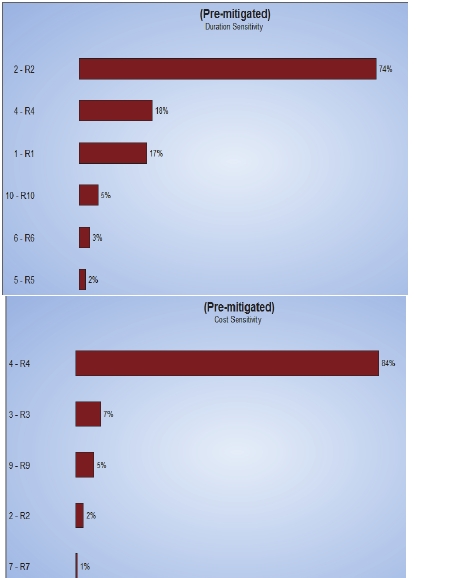
Fig. 8. Simulation of the final cost of the project for three plans